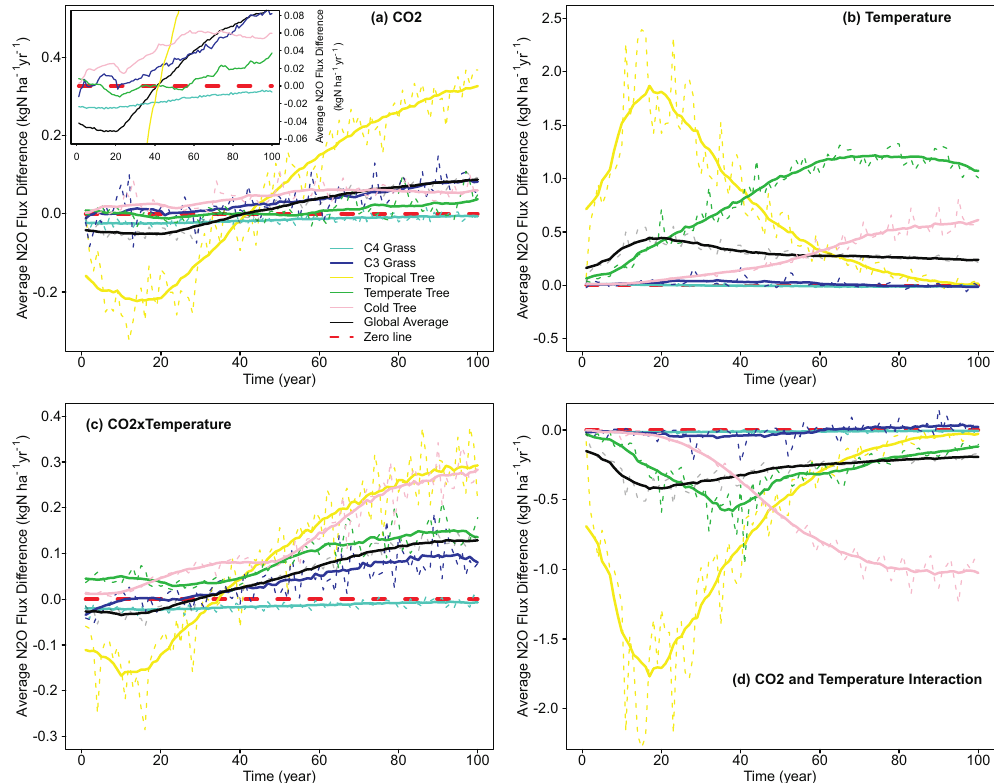
Figure 8. Soil N 2 O emissions in response to step increases in atmospheric CO 2 and temperature. Panel (a) is the response to CO 2 fertilization alone, expressed as the difference between CO 2 increased run and the control run (CO2_FERT – CONTROL), the inset zooms into the y axis (flux difference) around zero; panel (b) is the response to temperature increase alone (TEMP-CONTROL); panel (c) is the combined response to both CO 2 enrichment and temperature rise (CO2_FERT × TEMP-CONTROL); and panel (d) is the interactive effect of CO 2 and temperature responses, which is the difference between the combined (results from Panel c ) and minus the individual responses (results from Panel a and b ). Results are shown as annual values (thin dashed lines) and as running average with a moving window of 17years (period of recycled climate forcing, thick solid lines). The black lines represent the global average response. Coloured lines indicate responses for biome as represented by each plant functional type (PFT) considered in LM3V-N: C4 grass (cyan), C3 grass (blue), tropical forest (yellow), temperate deciduous forest (green) and cold evergreen forest (pink). Dashed red line represents the zero